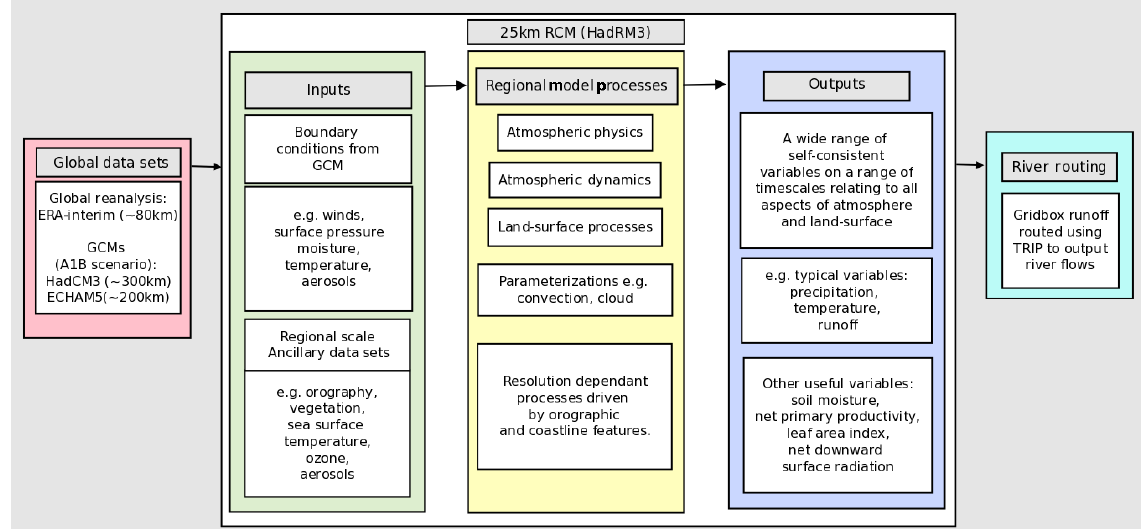
Figure 1. A flow chart showing the methodology for the presented